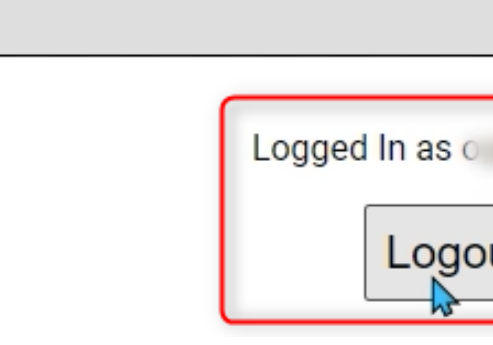
Figure 6. Successful Twitter